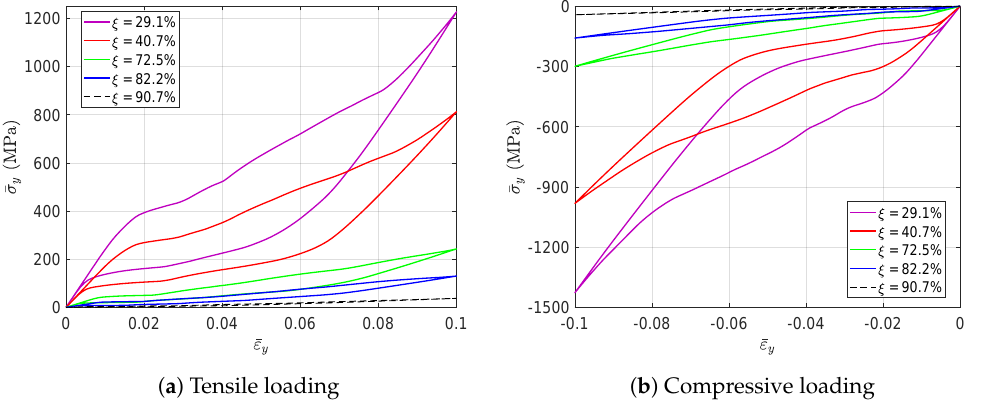
Figure 4. The evolution of the averaged stress-strain curves simulated by RVEs with different void